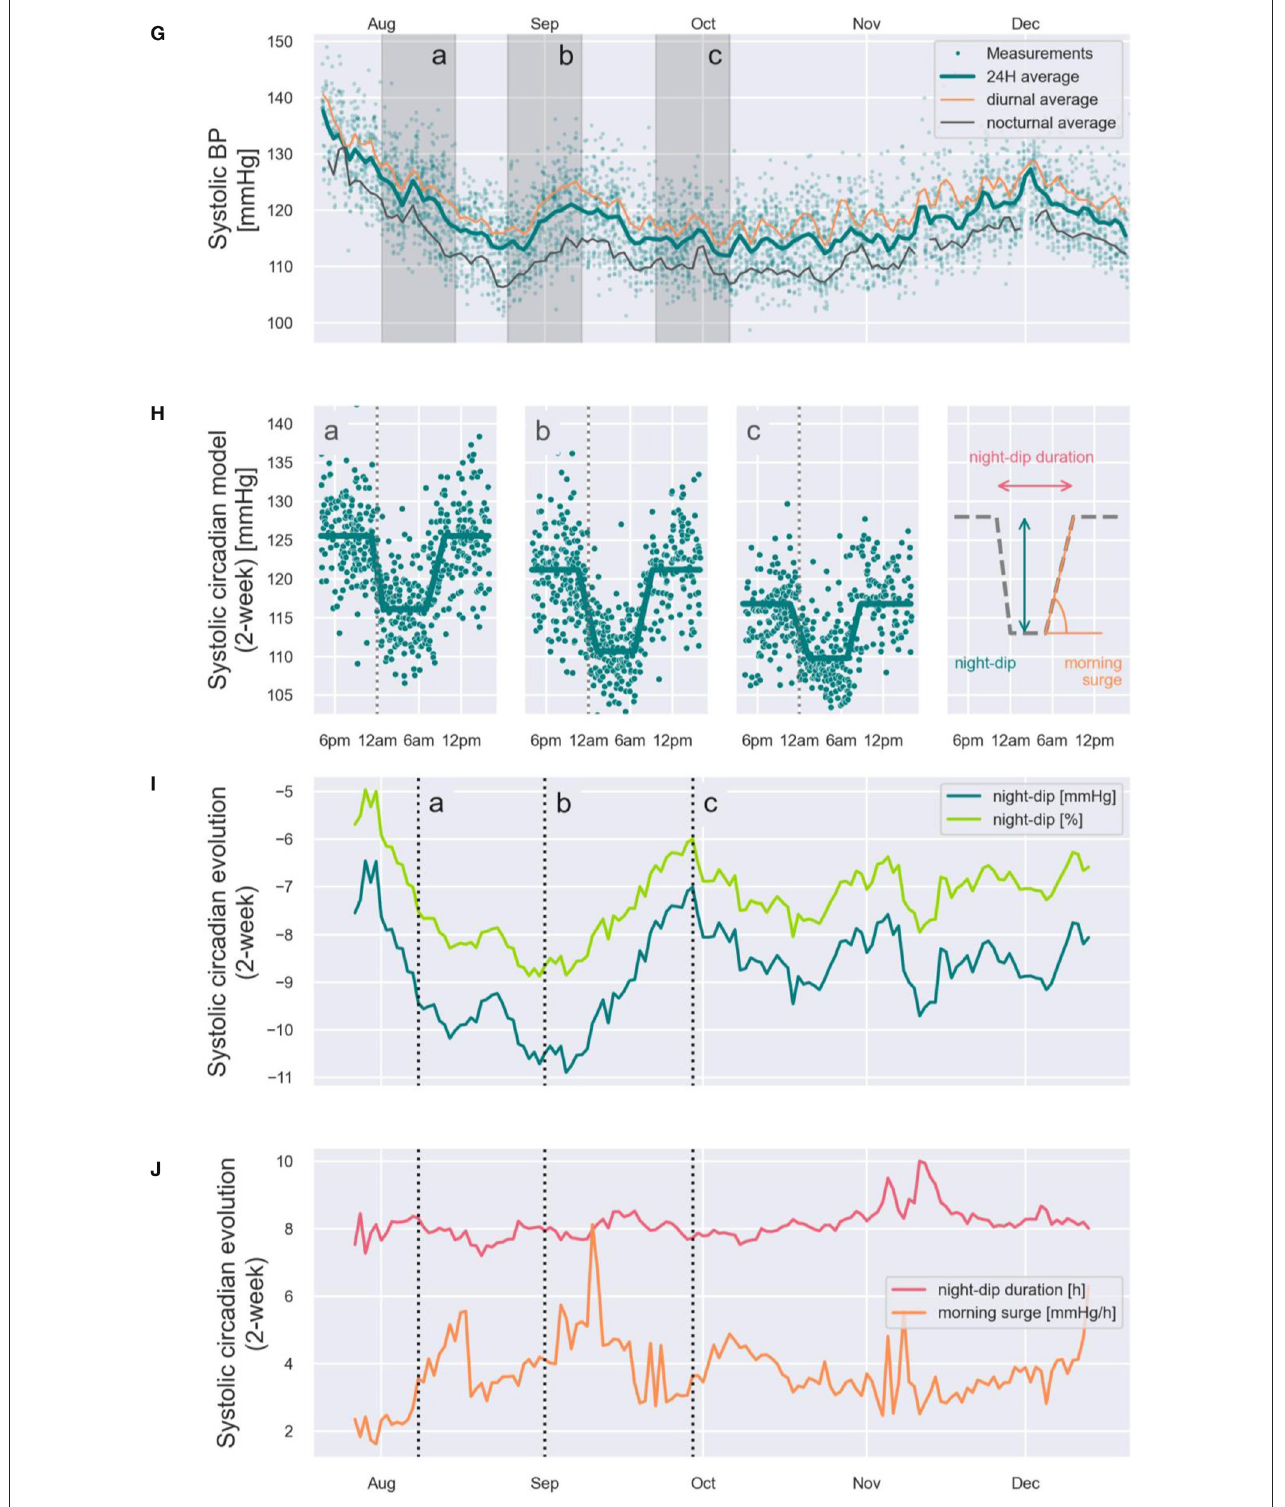
FIGURE 8 | Showcasing of the new generation of dynamic BP control metrics that can be generated from the data captured from continual cuffless BP monitors. The presented time series were captured on a subject over 5 months, and in addition to standard BP metrics such as 24h, daytime and nighttime averages of SBP, DBP and HR (A,C,E–G) it showcases novel dynamic metrics such as Time in Therapeutic Range [TTR, (B) ], SBP variability (D) , dynamic circadian models (H) , dynamic SBP night-dips (I) and dynamic night-dip durations and morning surge acceleration (J) .